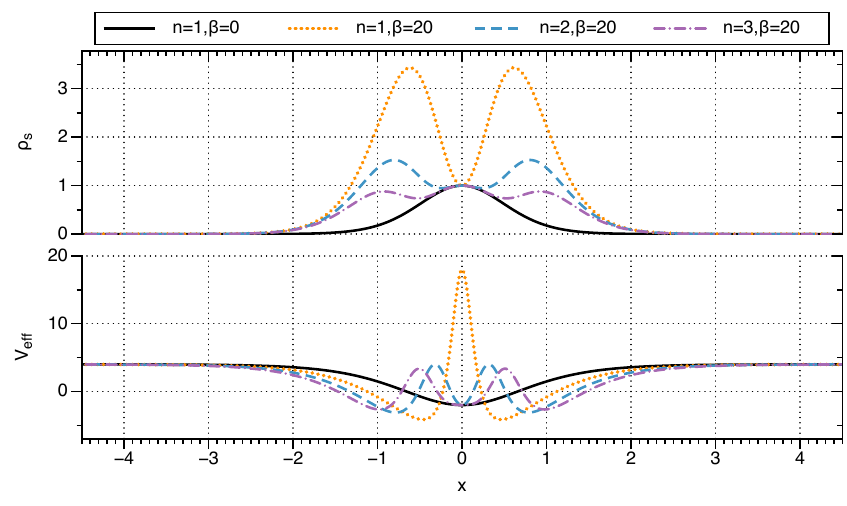
Figure 2 . The energy density (cid:26) ( x ) and the e(cid:11)ective potential V e(cid:11) .